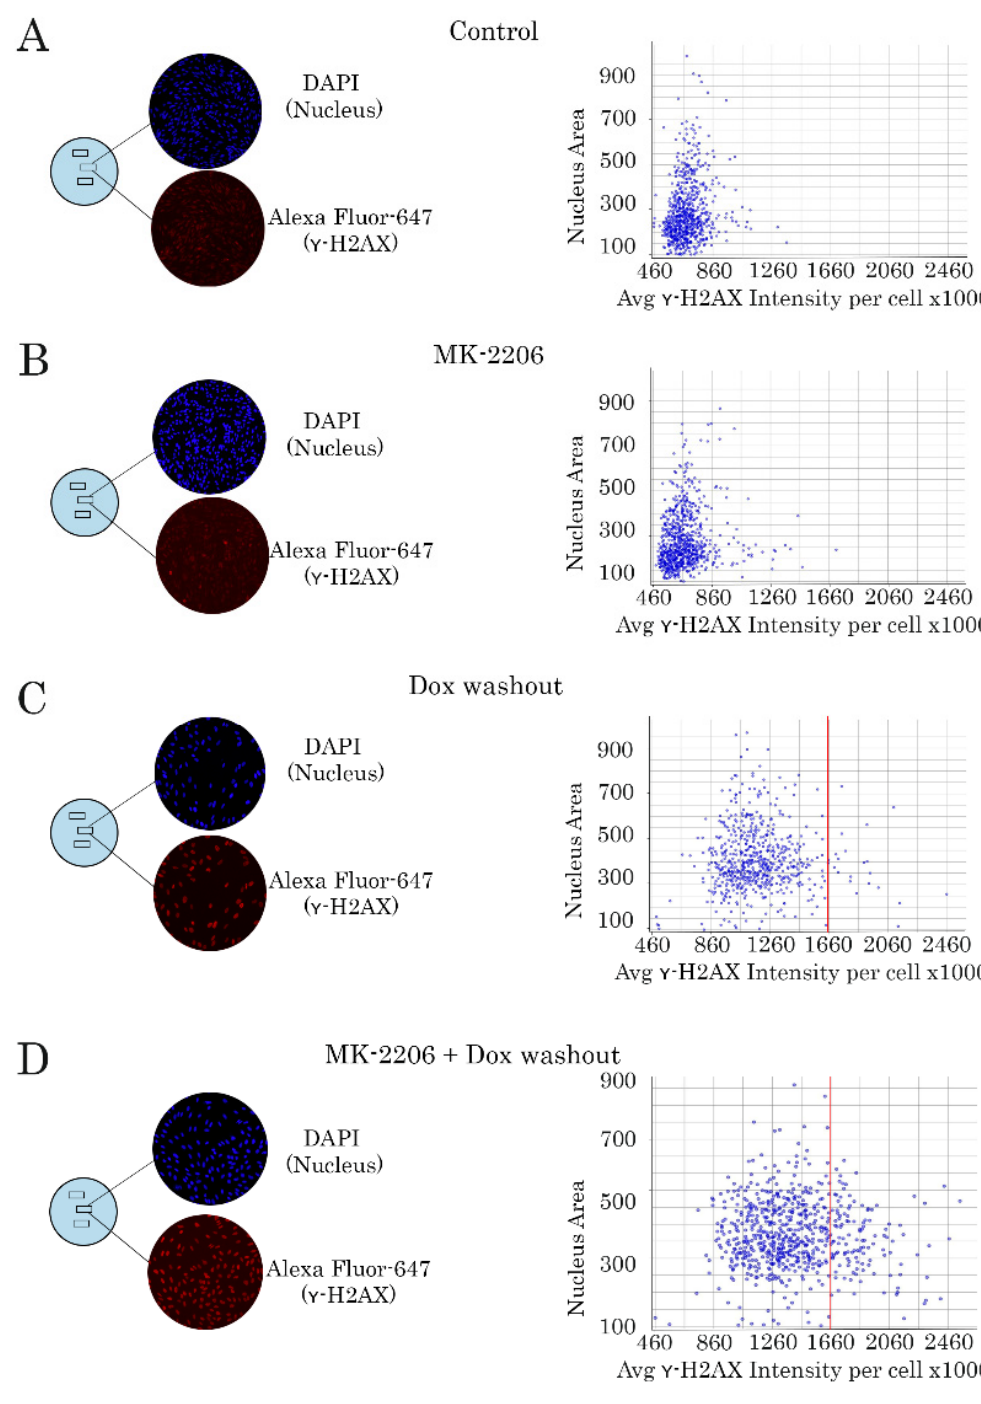
Figure 4. Inhibition of AKT-signaling delays the kinetics of γ -H2AX decline in Dox-treated GIST T-1R cells (representative experiment). Left panel-cancer cells were treated with DMSO (negative control) ( A ), MK-2206, a selective AKT inhibitor (5 µ M) ( B ), and Dox (0.5 µ g / mL) for 2 h. The cells were further washed from the compounds indicated above and cultured for 8 h in absence (Dox washout) ( C ) or presence of MK-2206 (Dox washout + MK-2206) ( D ). Right panel-histograms illustrating the intensity of γ -H2AX-specific fluorescence at the single-nucleus level. GIST T-1R cells were grown on slides for 24 h and treated with Dox and MK-2206 as indicated above. Cells were fixed with paraformaldehyde and stained with DAPI (blue) and γ -H2AX-specific antibody (red). The intensity of γ -H2AX-specific fluorescence was measured for each nucleus (DAPI) and calculated automatically. All images were acquired by GE Cytell imager as shown in Section